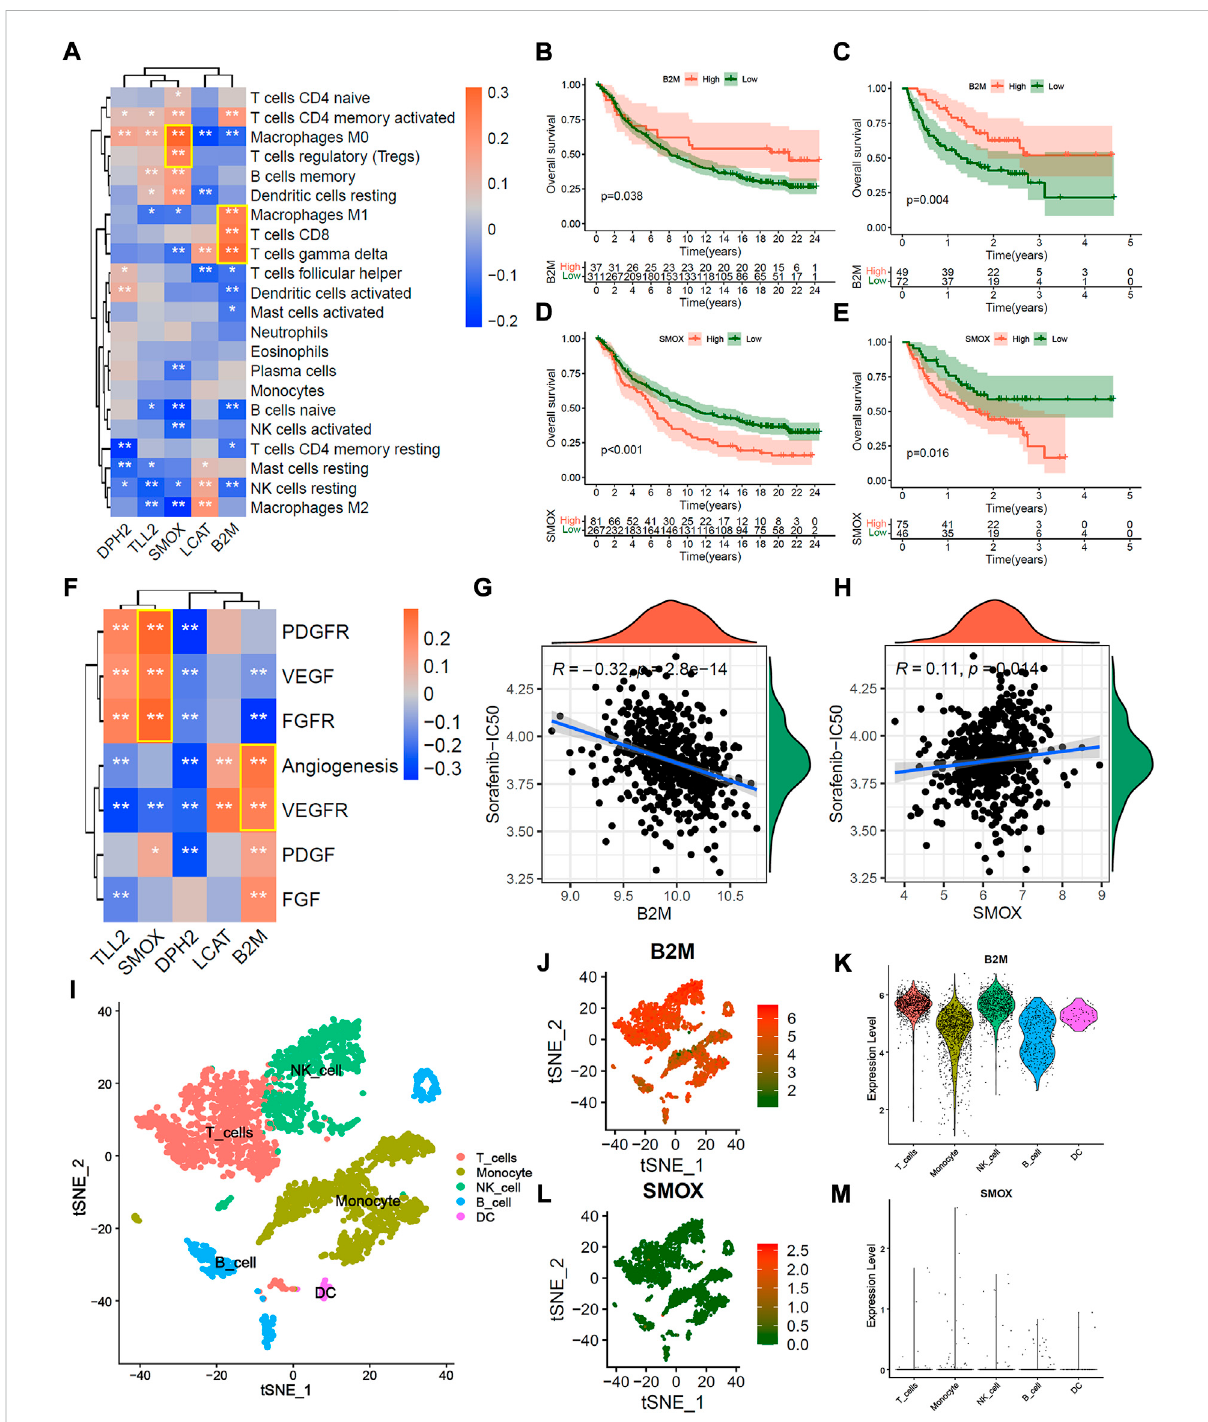
FIGURE 8 Potential mechanism of 5 hub genes in immunotherapy and anti-angiogenic therapy. (A) correlation heatmap between 5 hub genes and 22in fi ltrationimmunecells. (B , C) OverallsurvivalKaplan-MeieranalysisbetweenpatientswithhighandlowB2MexpressioninIMvigor210cohort (B) and Liu et al. Cohort (C) . (D , E) Overall survival Kaplan-Meier analysis between patients with high and low SMOX expression in IMvigor210 cohort (D) and Liu et al. Cohort (E) . (F) correlation heatmap of between 5 hub genes and the known vascular gene signatures score. (G , H) Correlation scatter plot of Sorafenib-IC 50 and the expression of B2M (G) and SMOX (H) . (I) The t-SNE plot of immune cell clusters in GSE140228 single immune cell cohort. (J , K) B2M expression in the t-SNE plot (J) and violin plot (K) . (L , M) SMOX expression in t-SNE plot (L) and violin plot (M)